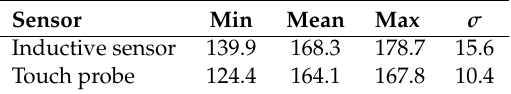
Table 1. Time, in seconds, needed to calibrate the